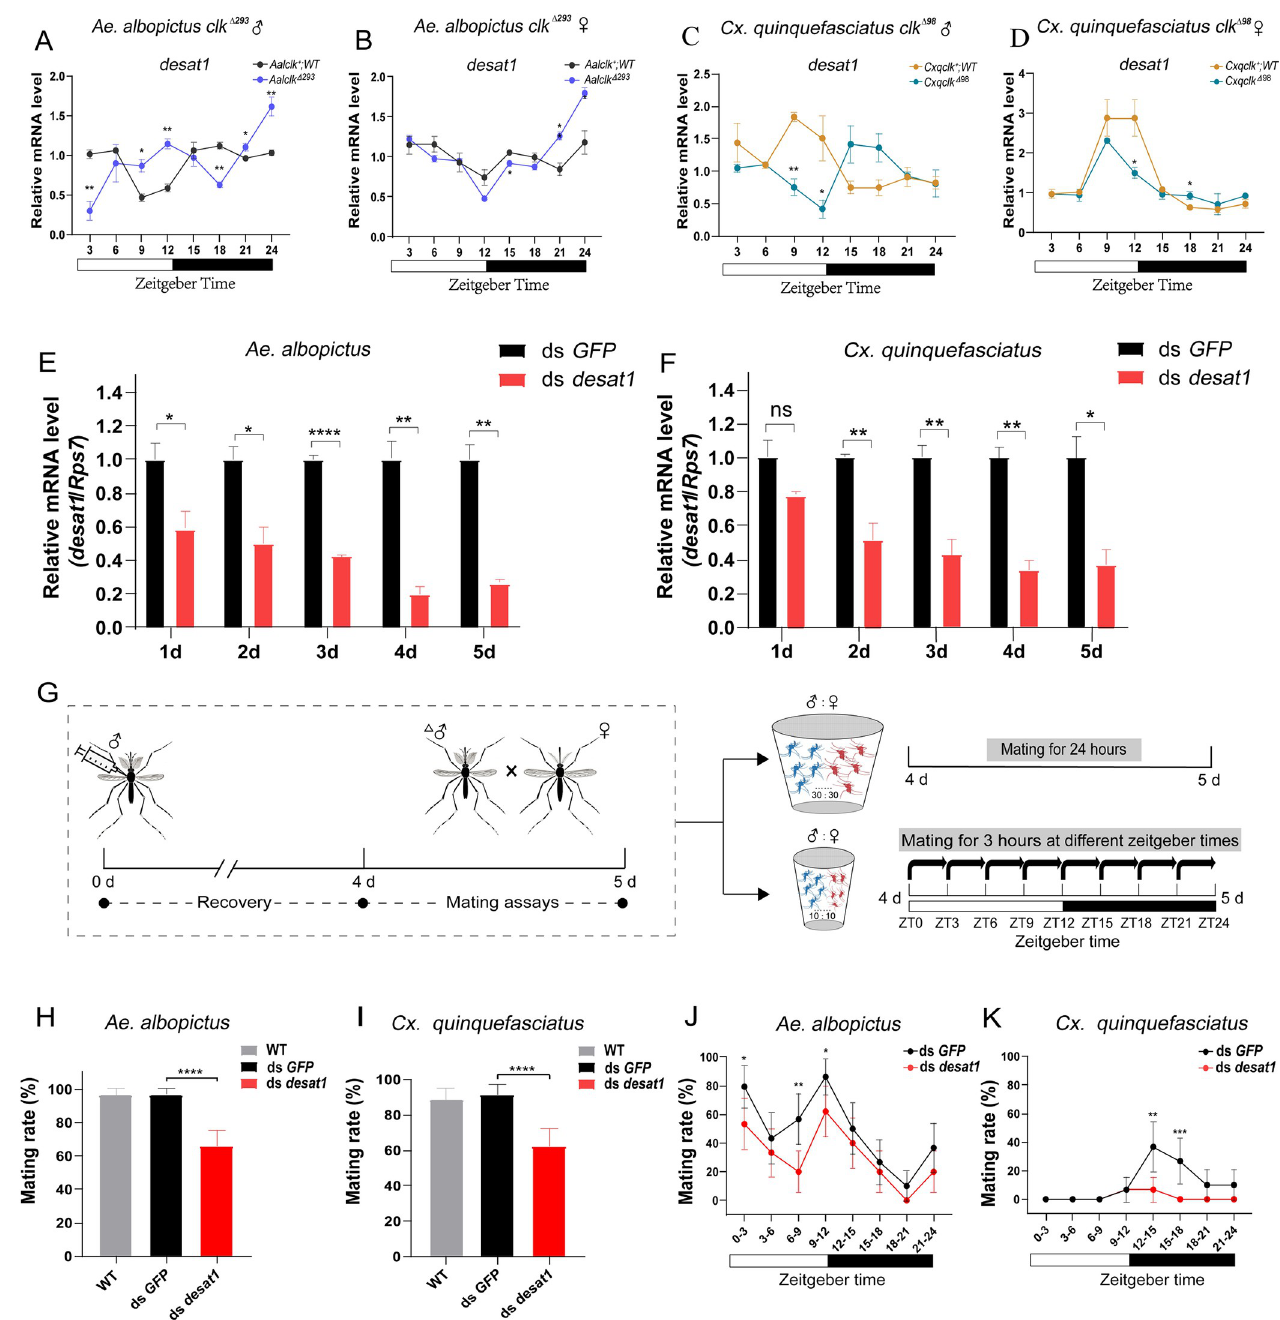
Fig 3. Changes in temporal expression of desat1 in Ae . albopictus and Cx . quinquefasciatus after clk -knockout and effects of desat1 on mosquito mating activity. ( A-D ) The expression pattern of desat1 at different times of a day in WT and clk mutant mosquitoes heads under LD cycles. The housekeeping gene RpS7 was used as the internal control for qRT-PCR. Data were normalized to median fold change. ( A ) WT ( Aalclk + ) and Aalclk Δ 293 males, ( B ) WT ( Aalclk + ) and Aalclk Δ 293 females, ( C ) WT ( Cxqclk + ) and Cxqclk Δ 98 males, ( D ) WT ( Cxqclk + ) and Cxqclk Δ 98 females. ( E-F ) Silencing efficiency of desat1 of male Ae . albopictus ( E ) and Cx . quinquefasciatus ( F ) injected with GFP and desat1 dsRNA. The X-axis represents days post thoracic injection (dpi) and Y-axis represents genes relative transcript accumulation. Statistics were performed using Student t-test and error bars represent the standard error of mean (SEM). Each treatment was replicated three times. ( G ) Experimental flow chart of the effect of desat1 gene on mating behavior of Ae . albopictus and Cx . quinquefasciatus , and ‘ Δ ’ represents male mosquitoes injected with dsRNA. ( H-I ) Effects of silencing desat1 expression on mating activity in male Ae . albopictus (H ) and male Cx . quinquefasciatus ( I ). A total of 30 injected males on 4 dpi were exposed to 30 virgin females in paper bowls. Mating assay was started at ZT9 and they were exposed for 24h. Gray, black and red columns represent WT group, the injection group of GFP dsRNA and the injection group of desat1 dsRNA, respectively. n = 88–90 for each treatment. ( J-K ) Effects of silencing desat1 on mating rhythm of Ae . albopictus ( J ) and Cx . quinquefasciatus ( K) under LD cycles. The black